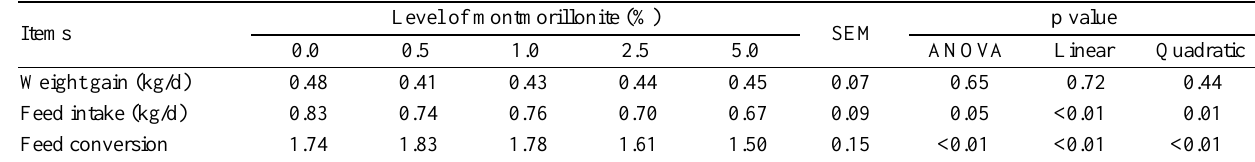
Table 2. Performance of weaned pigs fed diets containing graded levels of montmorillonite (d 0 to 28) 1